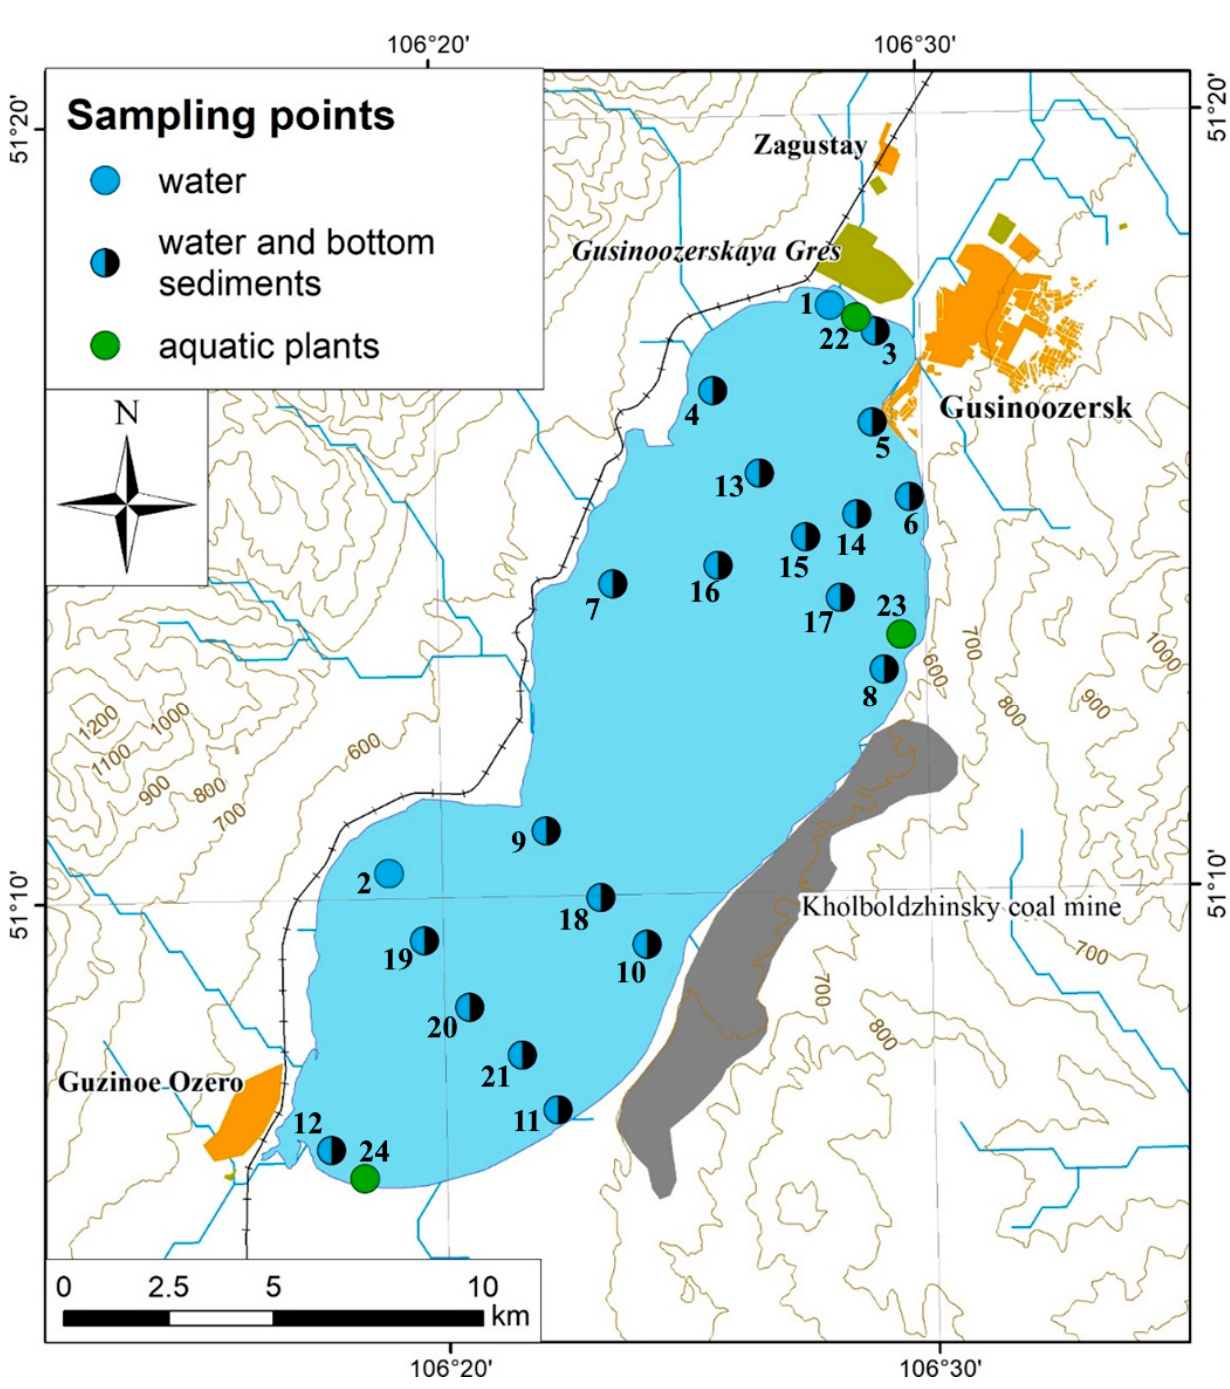
Figure 3. Sampling points for water, BS and aquatic plants at Lake Gusinoe. Samples of BSs were taken from the surface layer with a Petersen dredger with a grab area of 250 cm 2 and stored in polyethylene bags. Submerged macrophytes: